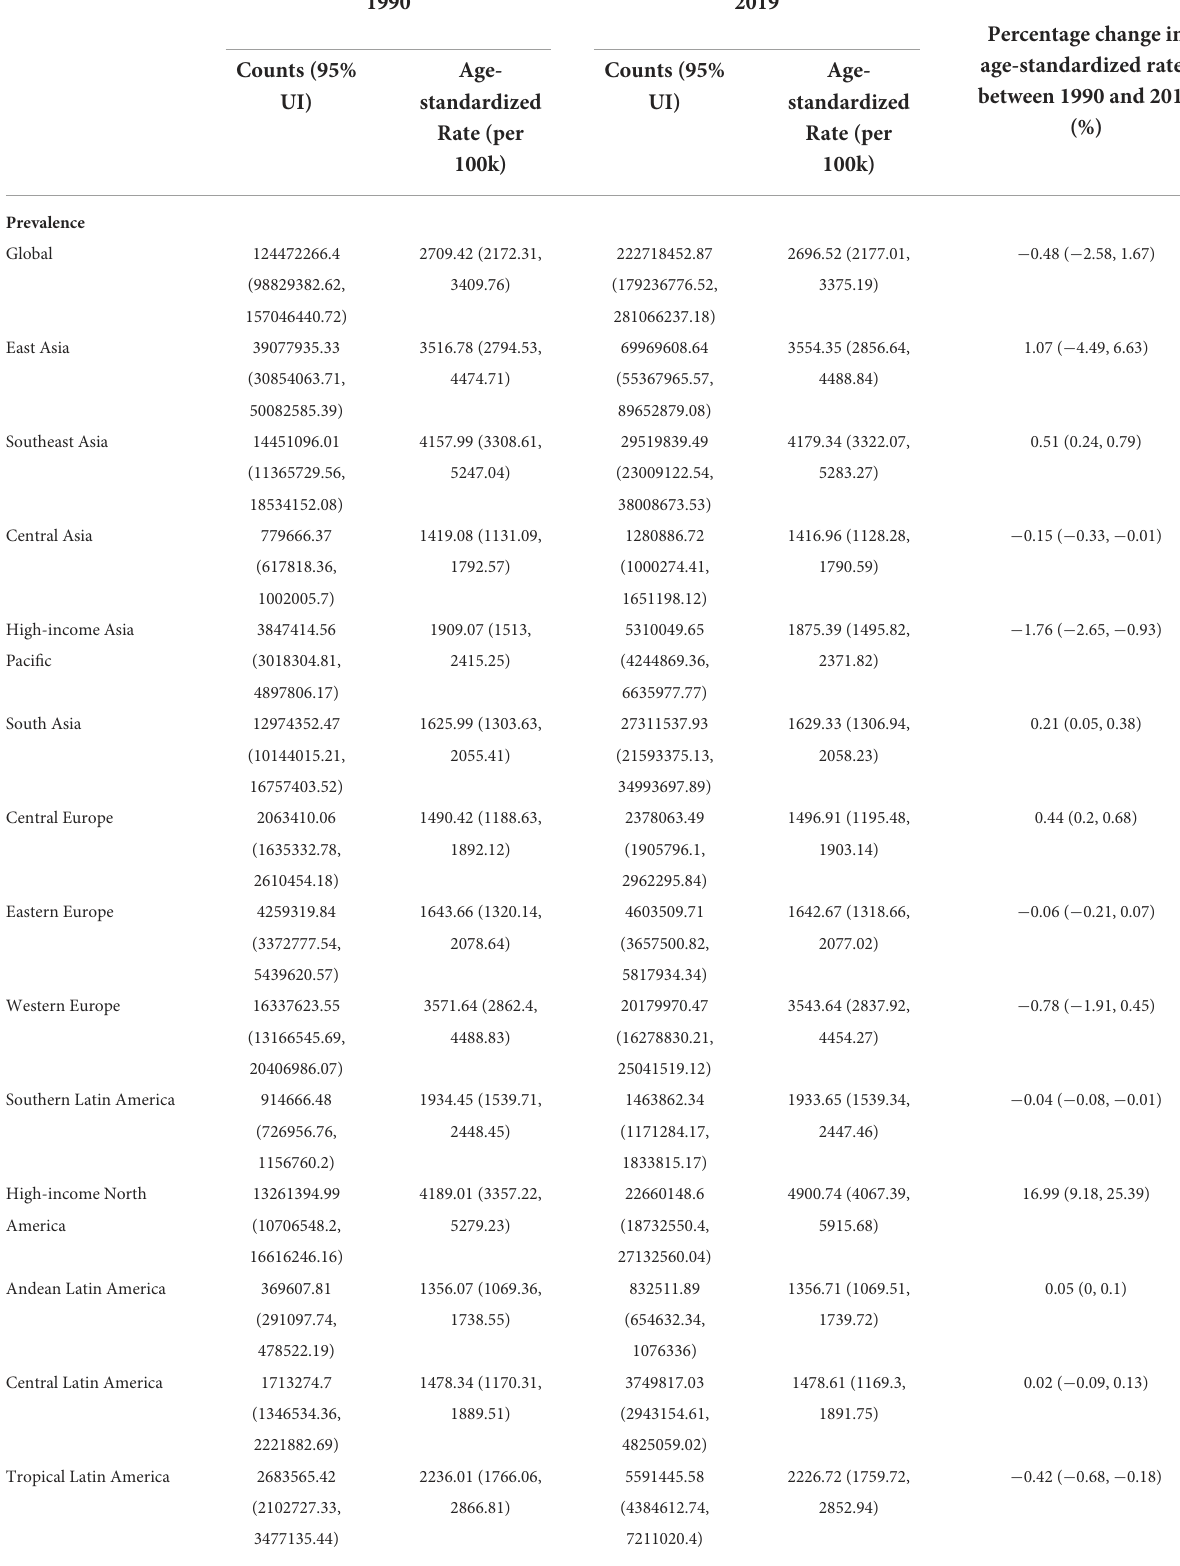
TABLE 1 Prevalence, incidence, and YLDs of neck pain in counts and age-standardize rate for both genders combined in 1990 and 2019, with percentage change between 1990 and 2019 by GBD